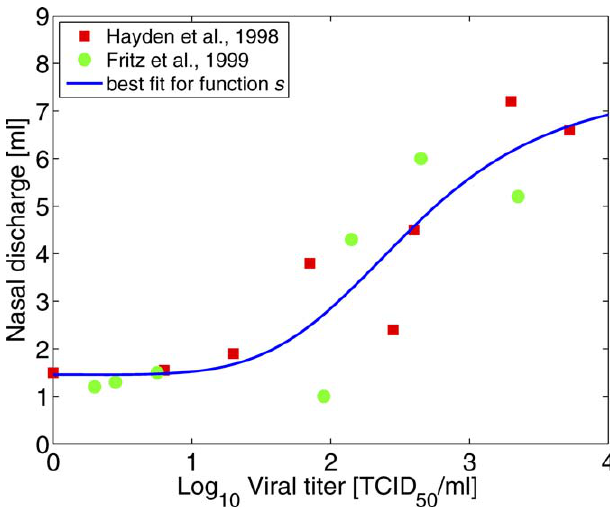
Figure 2. Nasal Discharge Weight as a Function of Viral Load Data are from [42] (squares) and [43] (circles). Also shown is the best fit for the function s (Equation 1). Note that daily discharge is measured in grams; we make the approximation that one gram corresponds to 1 ml in